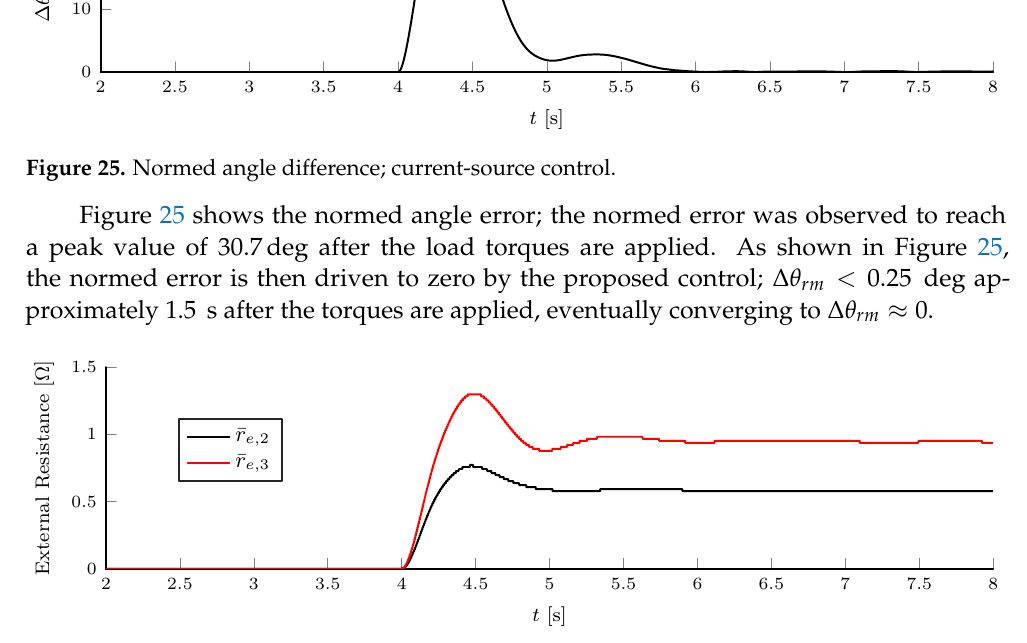
Figure 26. Fast-average external resistance values; current-source control.